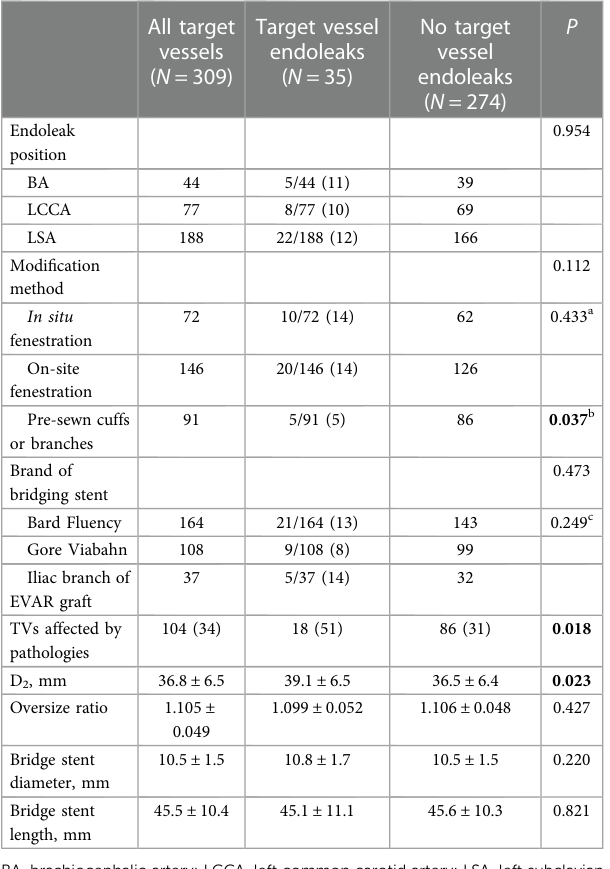
TABLE 4 Univariate and multivariate analyses of risk factors for target vessel (TV)-related endoleaks among 309 TVs after fb-arch